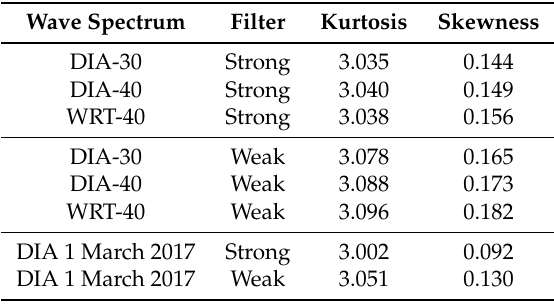
Table 1. Kurtosis and skewness average values for an ensemble of 20 HOS simulations for each set up.